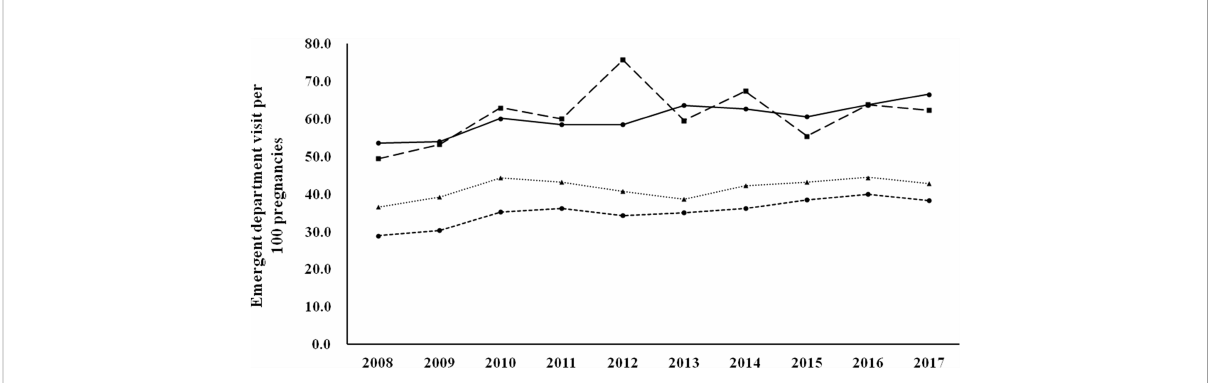
FIGURE 2 Number of emergency department visits per 100 childbirths from 2008 to 2017 according to the diagnostic categories. Circle spots and solid line, known DM. Square spots and dashed line, newly diagnosed DM. Triangle spots and dashed line, GDM. Circle spots and dashed line, no DM/ GDM. P for trend <0.001 for known DM and no